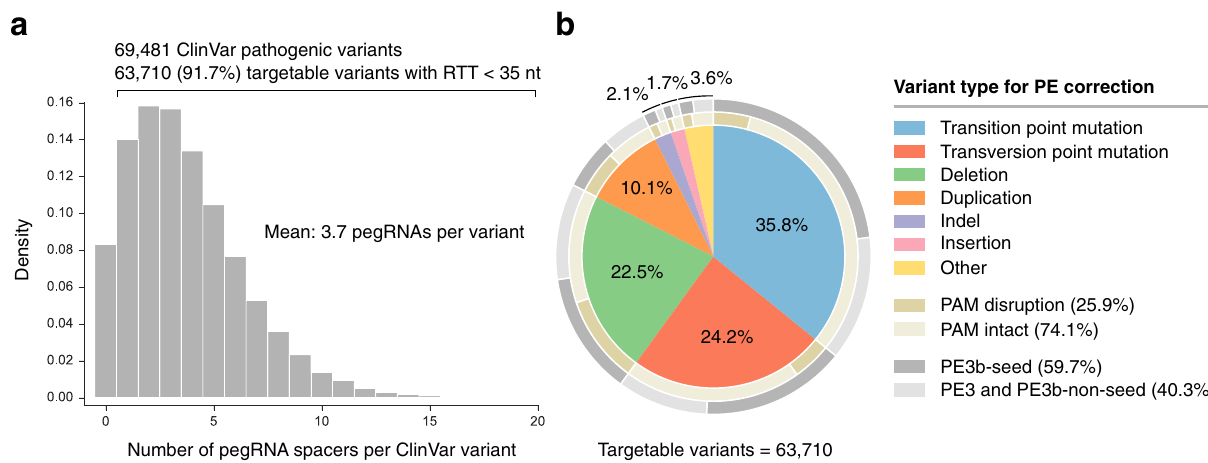
Fig. 2 PrimeDesign analysis of the ClinVar database. a The distribution of the number of designed pegRNA spacers per ClinVar variant. Candidate pegRNAs were determined based on the requirement of RTT length <35 nt and the RT extension to have a minimum homology of 5 nt downstream of the edit. b The 63,710 (91.7%) targetable ClinVar variants classi fi ed by type. The inner ring (gold) represents the proportion of targetable variants by type where at least one pegRNA could be designed to disrupt the PAM sequence (dark gold). The outer ring (gray) represents the proportion of targetable variants by type where at least one ngRNA could be designed for the PE3b strategy where the mismatch lies in the seed sequence (PAM-proximal nucleotides 1 – 10) (dark gray). See Supplementary Data 1 for details.